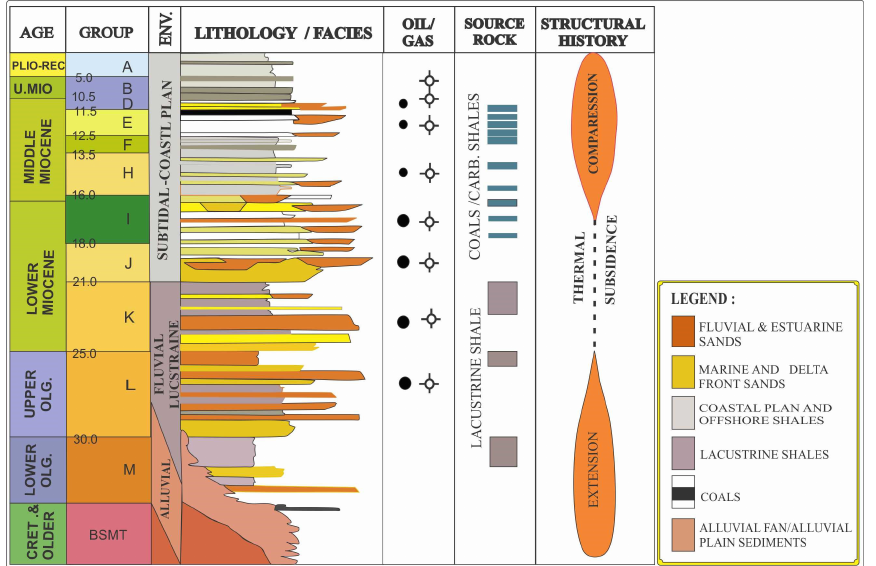
Figure 2. A layout shows the generalized stratigraphy and structural, historical column of the Malay Basin. The second column contains the main column of the successions of geographic stratigraphy and their approximate ages (categorized A–M) (in Mya), in addition to the dominant lithologies and possible associated facies, after Madon (1999)